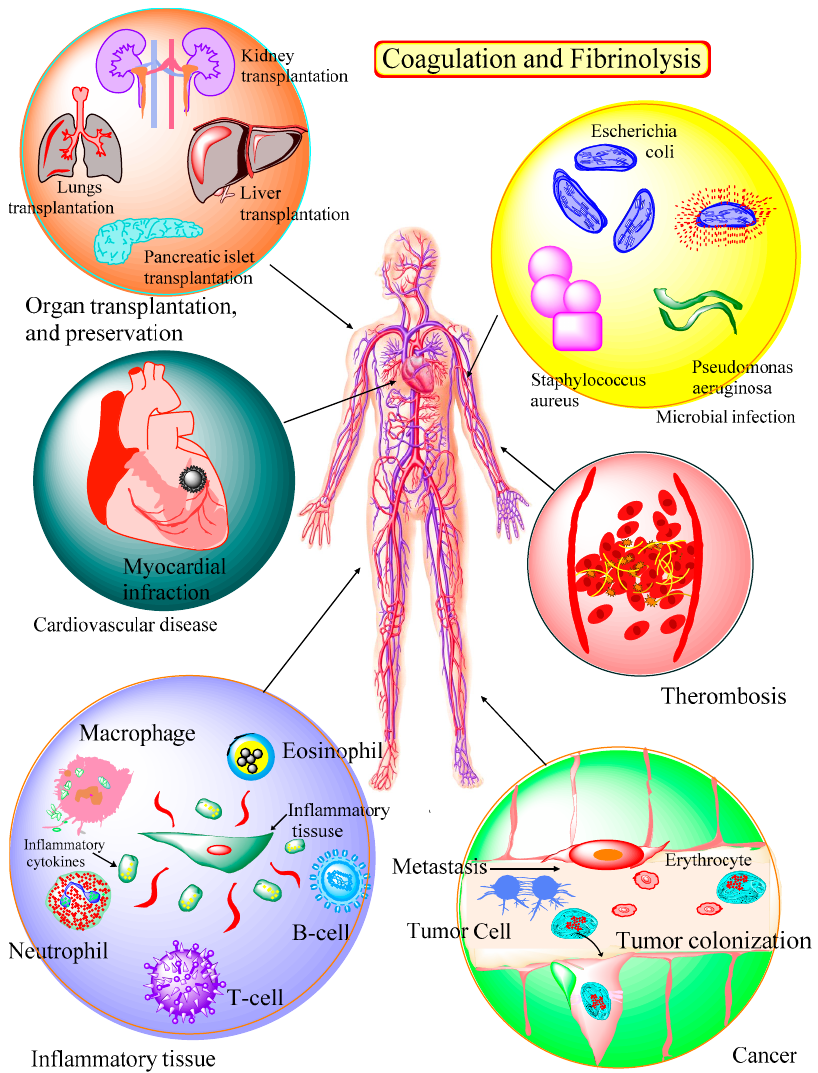
Figure 2. The coagulation and fibrinolysis scope of CO ‐ releasing materials (CORMats).